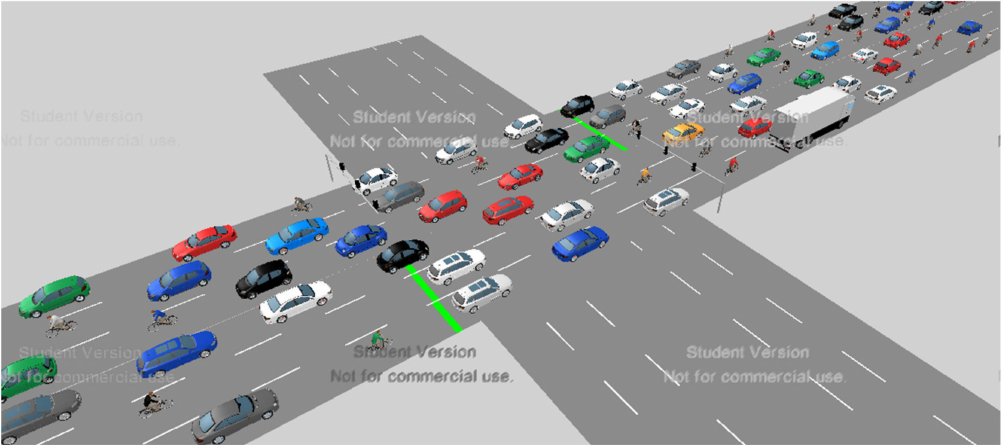
Figure 2. Simulation of low green traffic rate at